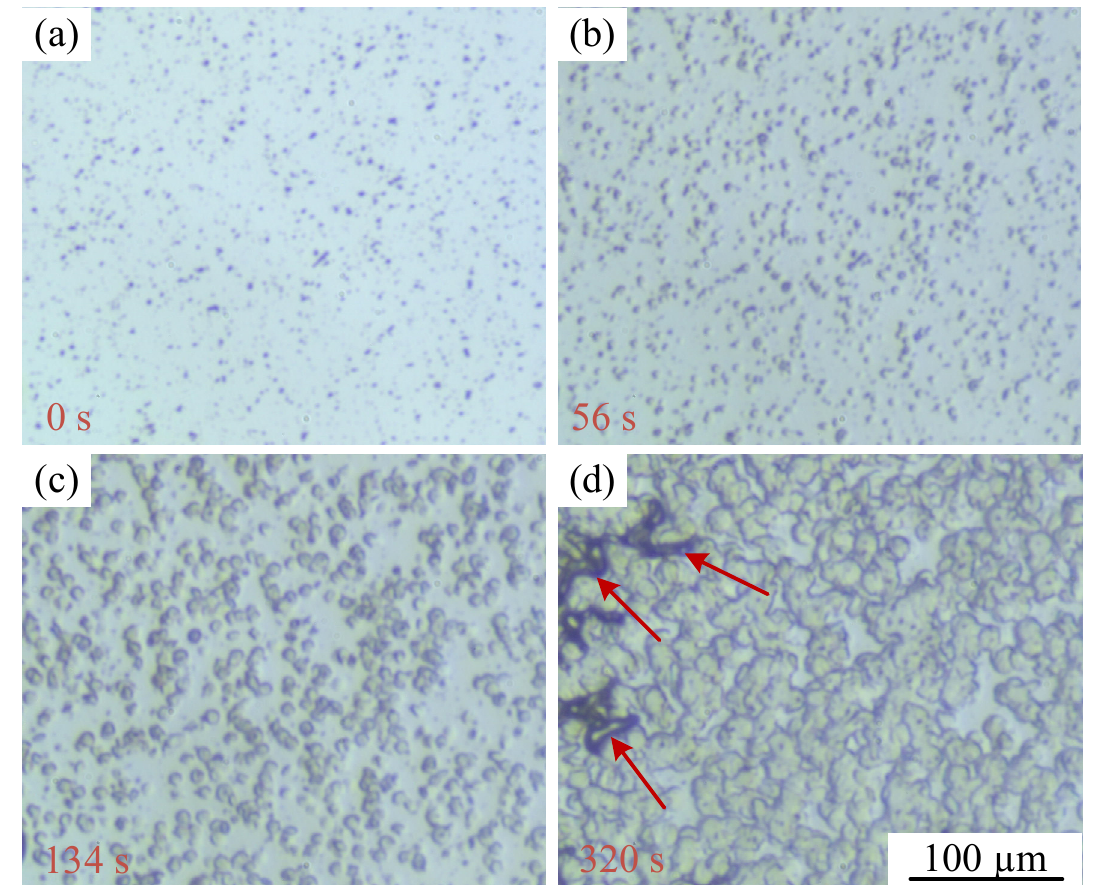
Figure 4. Grain morphology of PP/GN nanocomposite at 140 °C and 13.79 MPa, ( a ) 0 s, ( b ) 56 s, ( c ) 134 s and ( d ) 320 s.